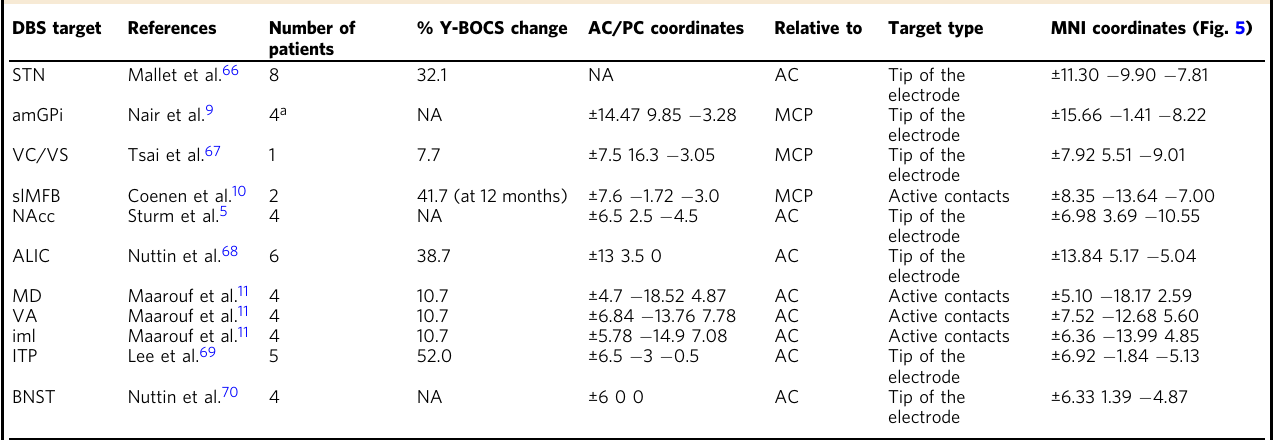
Table 2 DBS targets for treatment of OCD de fi ned in the literature.